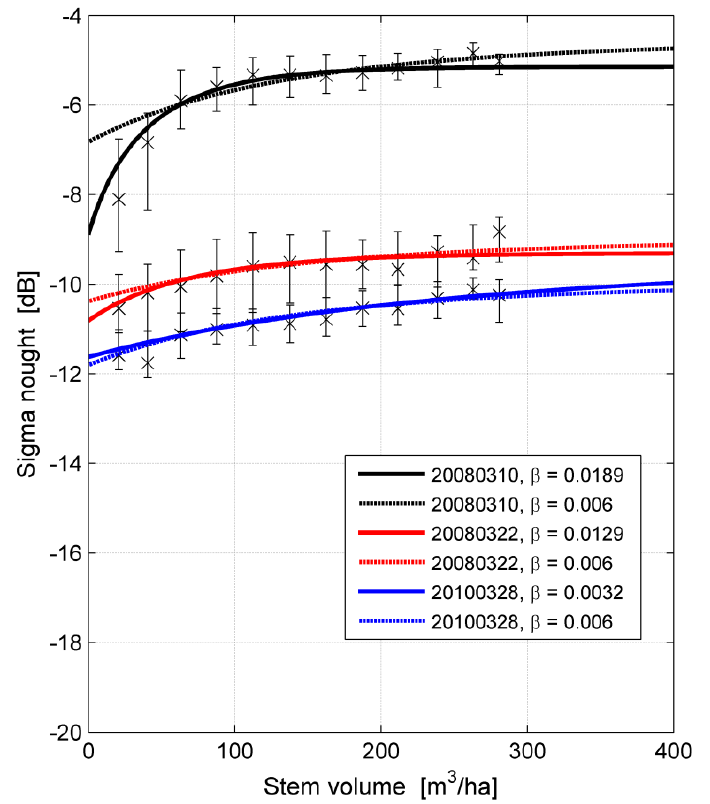
Figure 7. Three examples of modeled backscatter as a function of stem volume assuming β unknown (solid curves) and set a priori (dashed curves). The measurements of backscatter are represented by crosses and vertical bars (median and interquartile range) for groups of stem volume, each being 25 m 3 /ha wide. Test site: